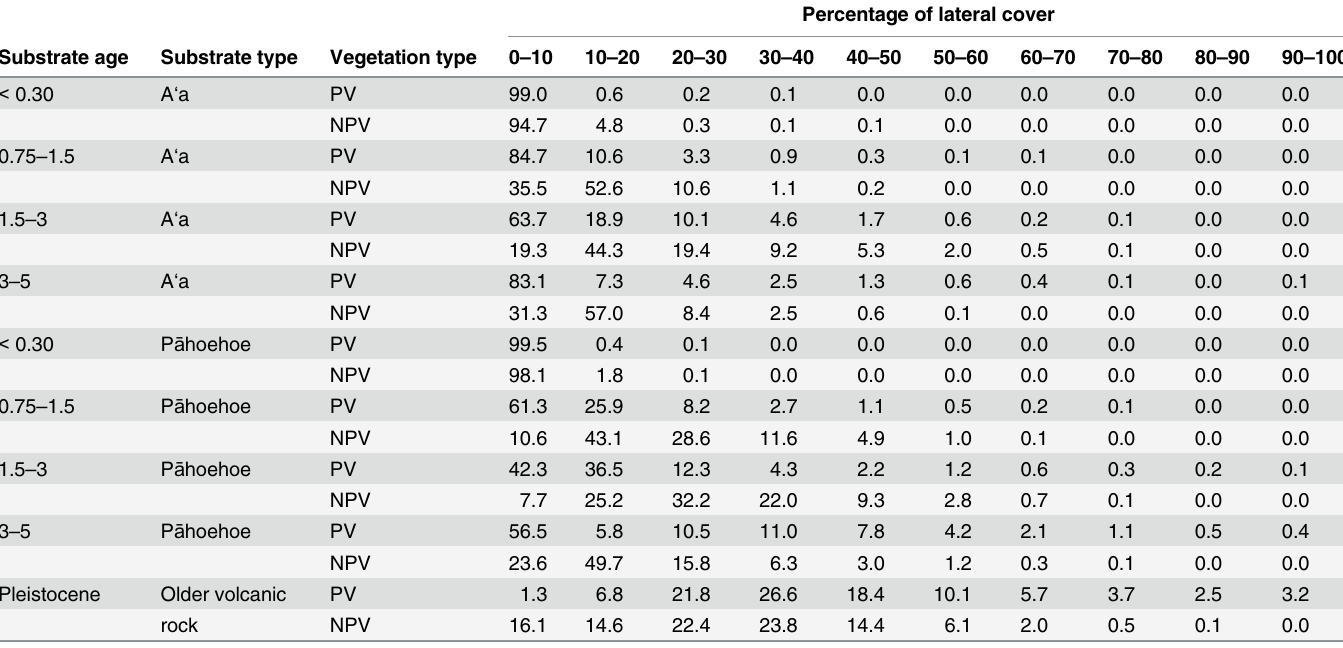
Table 3. Distributions of lateral vegetation cover on substrates of the P ō hakuloa substrate age gradient.